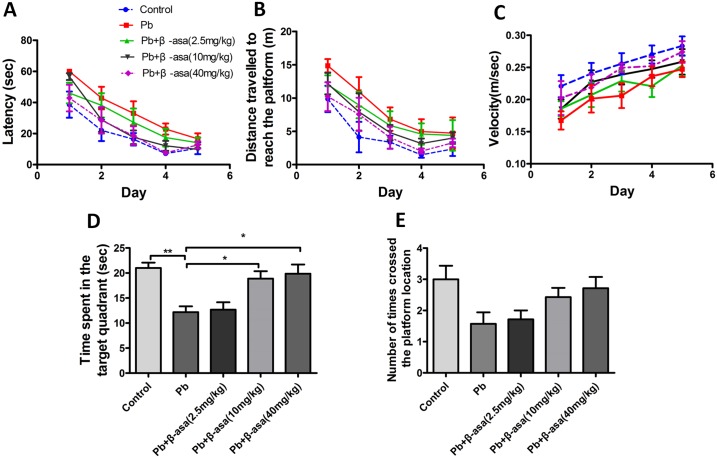
Effects of β-asarone on MWM tests in Pb-exposed adult rats.(A) Latency; (B) Distance travelled to reach the platform; (C) Swimming velocity during MWM tests; (D) Time spent in target quadrant; (E) Number of times crossed the platform in probe trial. (*P<0.05, **P<0.01, n = 7 per group).